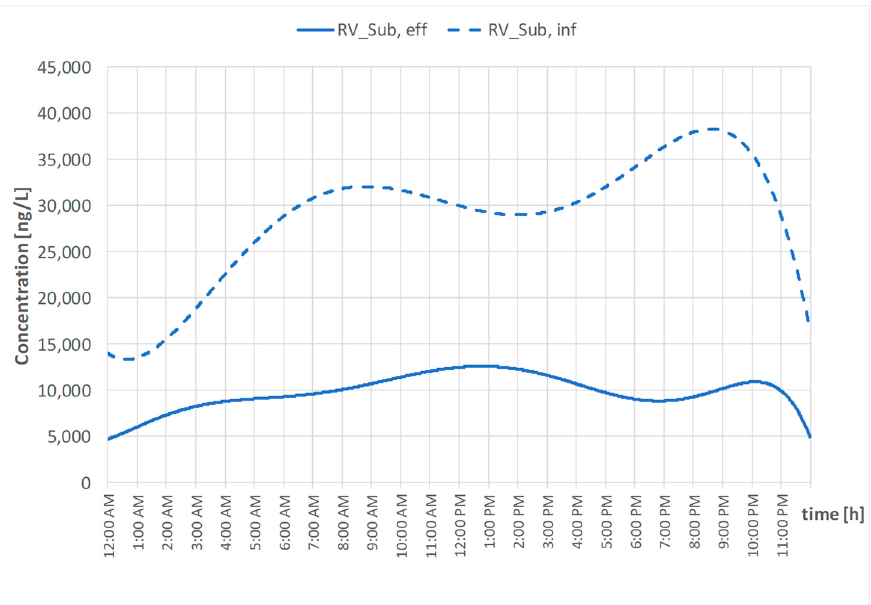
Figure 5. Occurrence of the same compound in a small wastewater treatment plant influent (dashed line) and effluent (continuous line). Table 2. Description of the sampling modes adopted and compared in this study for the removal efficiency evaluation of RV_Sub.